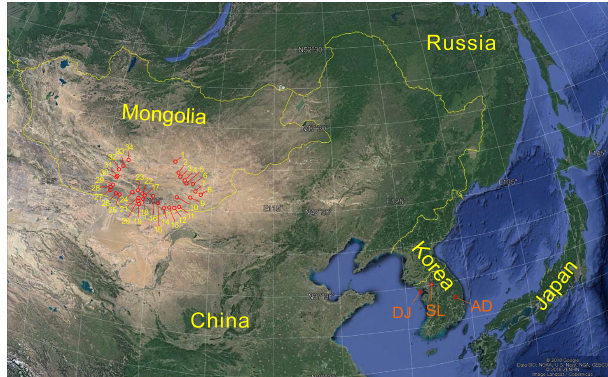
Figure 3. Three sites from which Asian dust samples were obtained on the Korean Peninsula, and the locations from which 34 soil sam- ples were obtained in the Mongolian Gobi Desert. See Table 1 for the sampling site and time during the dust events. AD denotes An- dong, DL denotes Deokjeok Island, and SL denotes